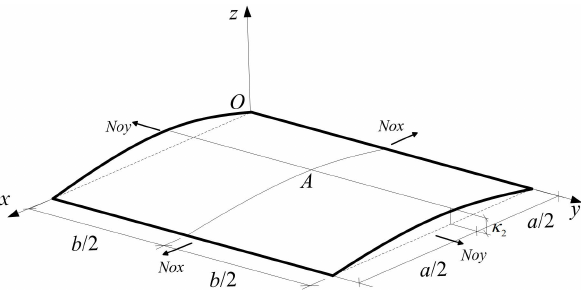
Figure 1: Skeleton supported membrane model with four edges